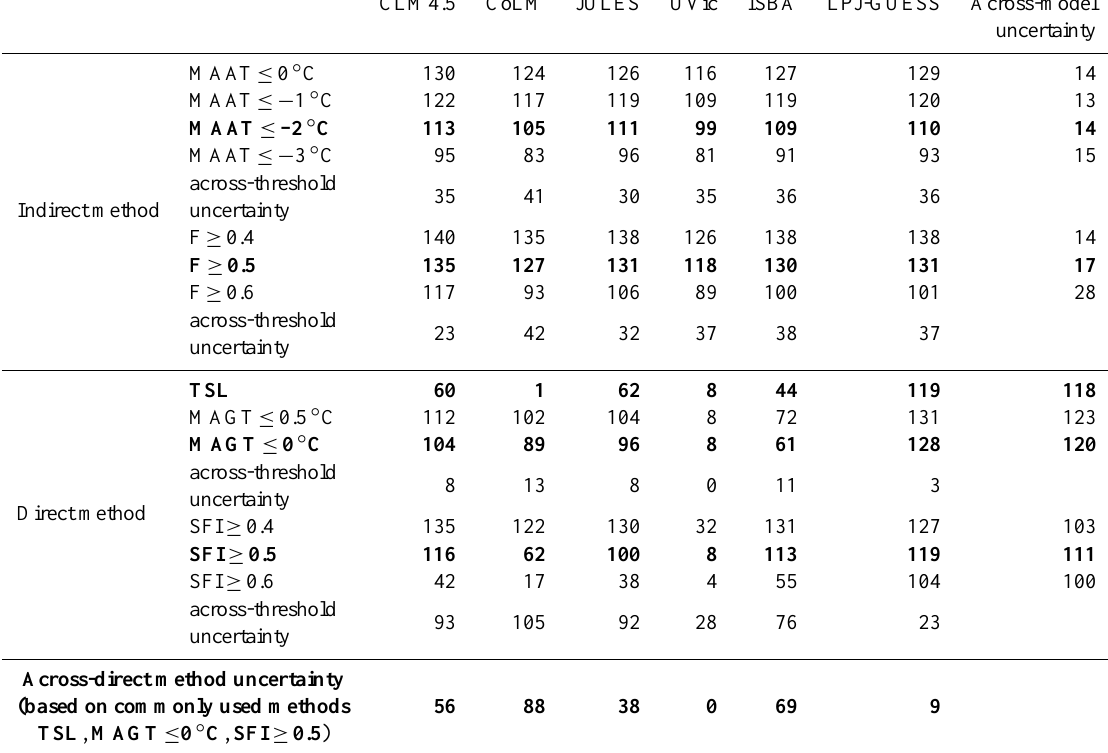
Table 3. Derived permafrost area inside the common modeling region on Tibetan plateau (10 4 km 2 ) from six LSMs and five diagnostic methods, using different thresholds. The results of thresholds commonly used in the literature and in this paper are marked in